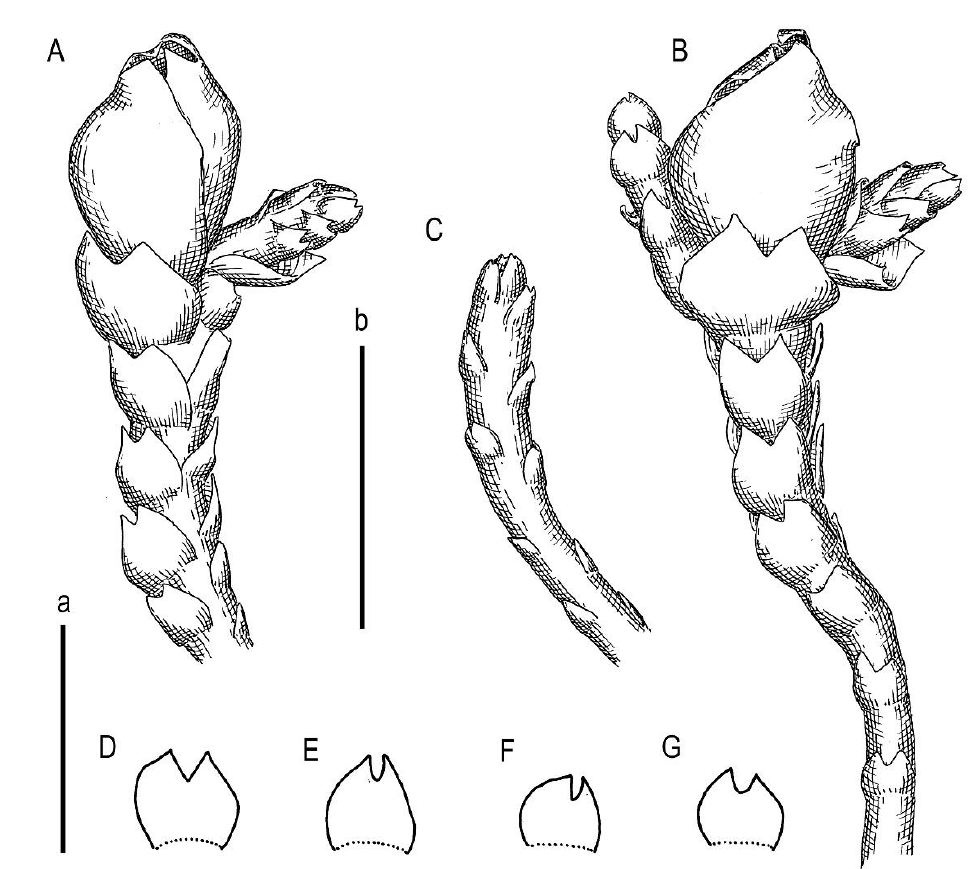
Figure 11. Marsupella vermiformis (R.M. Schust.) Bakalin et Fedosov: ( A ) perianthous shoot, fragment, lateral view; ( B ) perianthous shoot, fragment, lateral view; ( C ) sterile shoot, fragment, dorsal view; ( D – G ) leaves. Scale: a—500 µ m for ( D – G ); b—500 µ m for ( A – C ). All from Choi 120911 (VBGI).